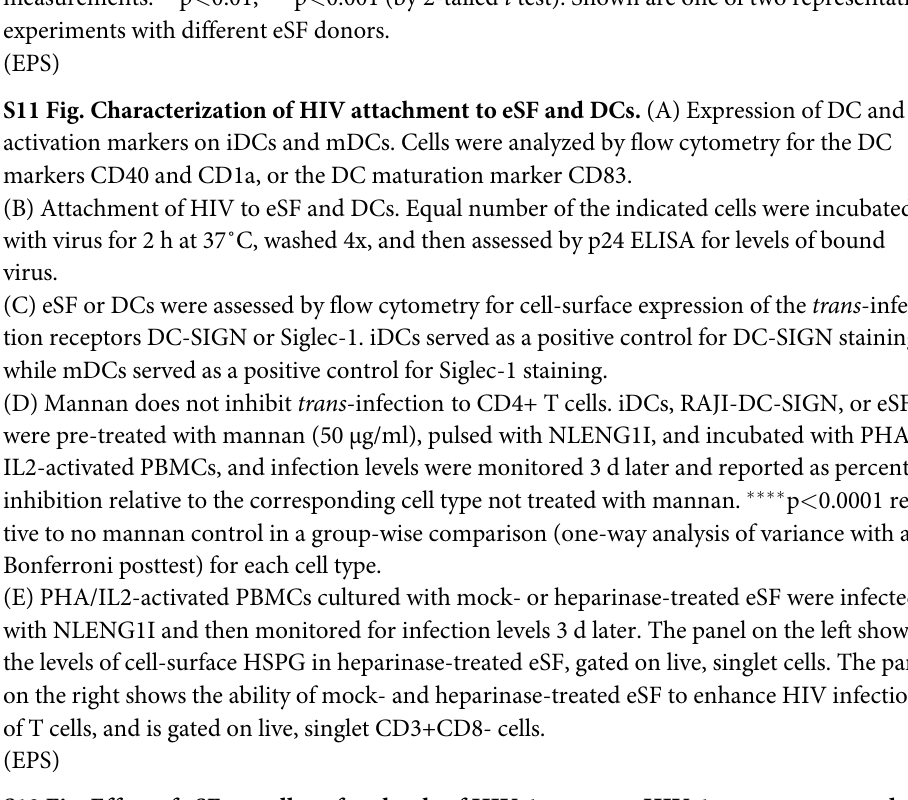
S12 Fig. Effect of eSF on cell-surface levels of HIV-1 receptor, HIV-1 co-receptors, and adhesion molecules on T cells. PHA/IL2-activated T cell were co-cultured for 3 d with eSF, and then assessed for cell-surface levels of CD4 or the co-receptors CXCR4 and CCR5 (A), or the adhesion molecules CD11a ( α -chain component of LFA-1), CD18 ( β -chain component of LFA-1) and CD54 (ICAM-1) (B). Unstained samples correspond to Fluorescence Minus One (FMO) controls. Results are gated on live, singlet CD3+CD8- cells, and are representative of one of two experiments using different sets of eSF and PBMC donors. S13 Fig. Comparison of HIV infection enhancement by eSF and 10-fold excess DCs. PHA/ IL2-activated PBMCs were infected with replication-competent NLENG1I (A) or replication- incompetent NL4-3.env (cid:3) GFP (B) in isolation, or in the presence of eSF, an equal number of DCs, or 10x the amount of DCs. Infection levels were monitored 3 d later by flow cytometry. Results are gated on live, singlet CD3+CD8- cells. (cid:3) p < 0.05, (cid:3)(cid:3)(cid:3) p < 0.001, and (cid:3)(cid:3)(cid:3)(cid:3) p < 0.0001 rel- ative to No co-culture control in a group-wise comparison (one-way analysis of variance with a Bonferroni posttest). S14 Fig. Stromal fibroblasts isolated from endometrium, ectocervix, and endocervix of the same subject enhance HIV infection of CD4+ T cells to similar extents. PHA/IL2-activated PBMCs were infected with NLENG1I in isolation, or in the presence of eSF, cSF, or cnSF. Infection levels were monitored 3 d later by flow cytometry. Results are gated on live,